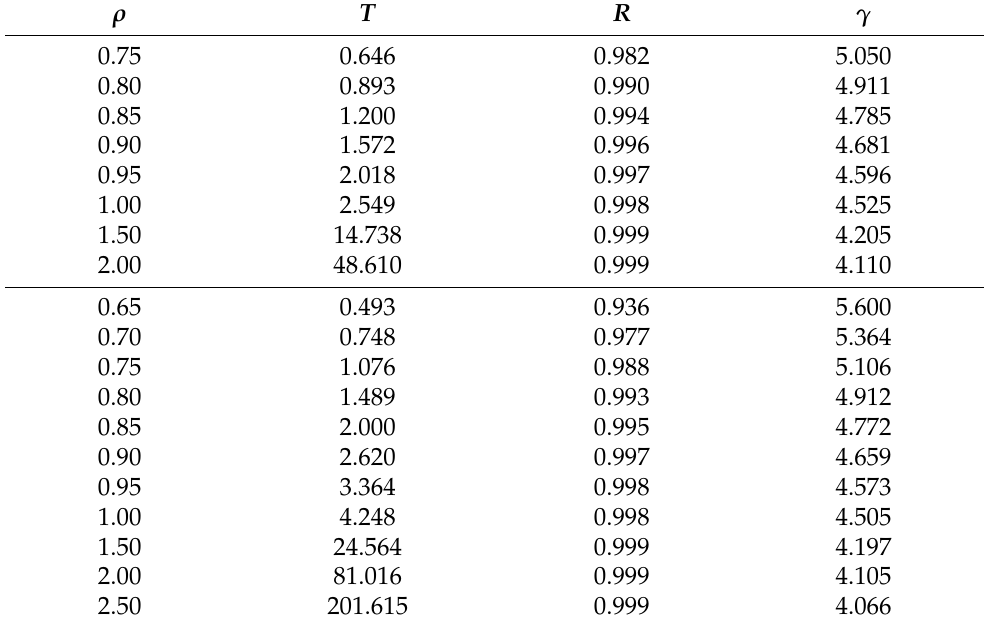
Table A2. Selected Wahnström state points of the ( ρ , T ) = (0.85, 1.2) reference-state-point isomorph (top) and the ( ρ , T ) = (0.85, 2.0) reference-state-point isomorph (bottom) (Figures